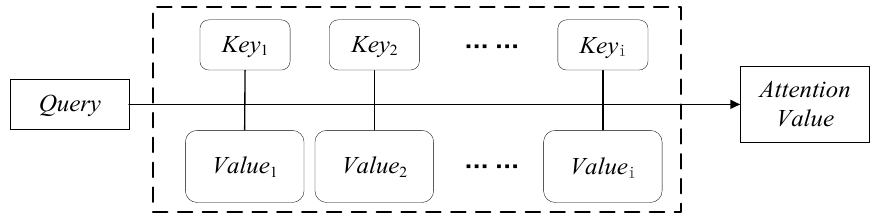
Figure 4. Principle of the attention mechanism.